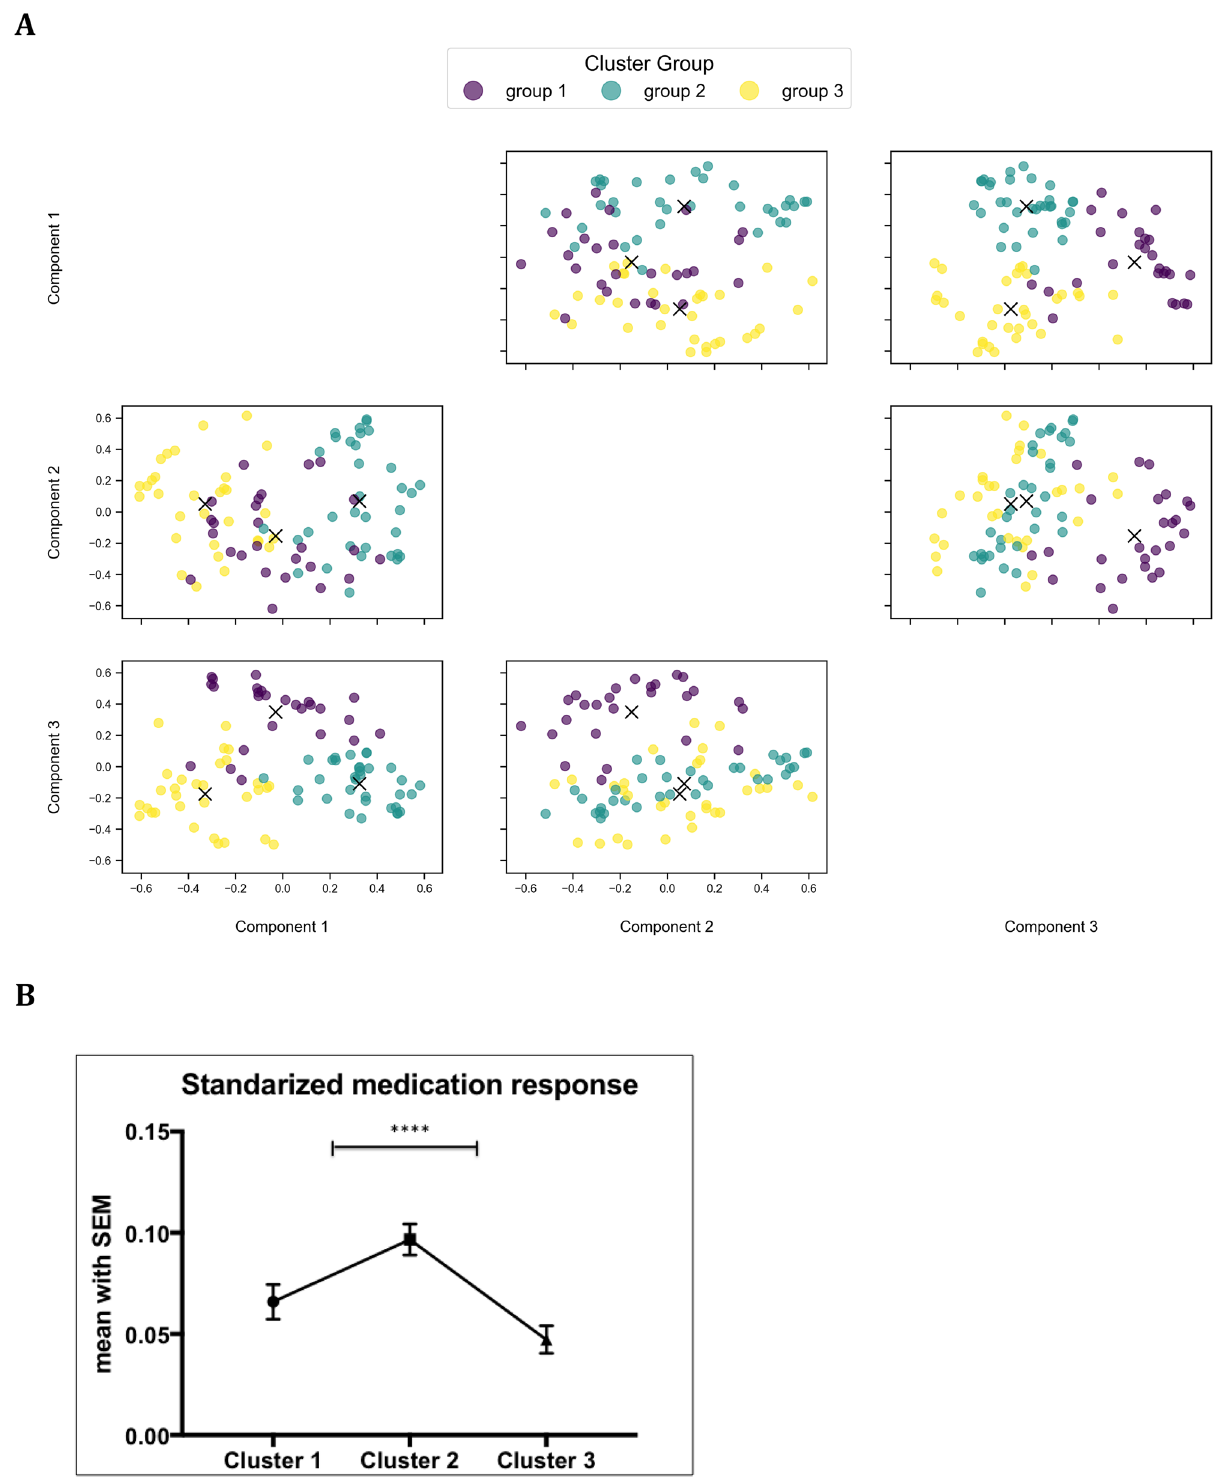
Figure 1. Overview of key results. ( A ) Results of kmeans-clustering with resulting three distinct groups (labeled in yellow, green and purple) exemplarily for the first three components (out of 8 components). ( B ) Cluster 2 showed the best medication response with a significant difference to cluster 1 and 3. Differences are marked at significance level of p < 0.0001